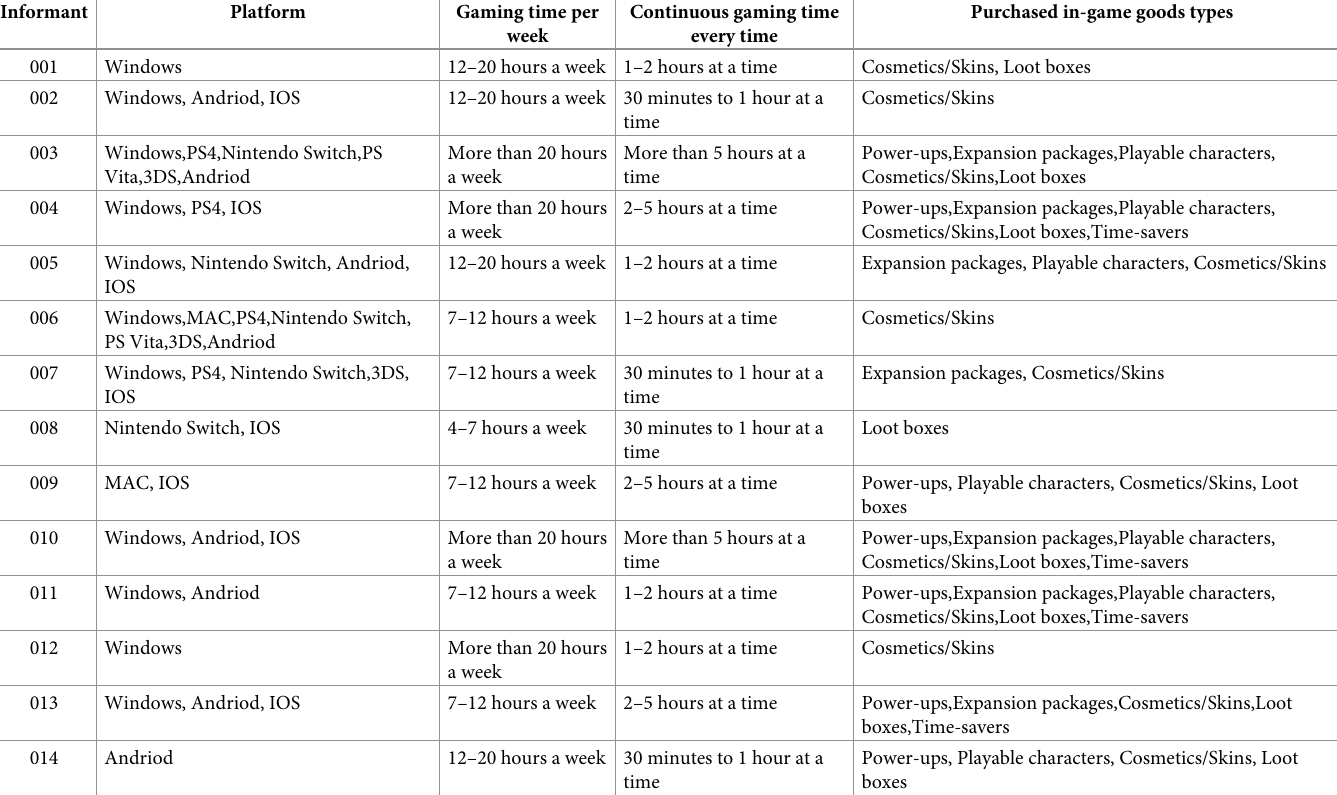
Table 3. Demographic profile of the